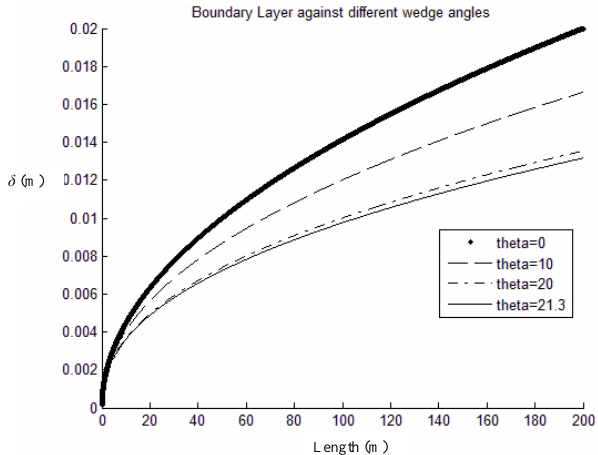
Fig. 3. The boundary layer depth against the length of the channel Fig 3. The boundary layer depth against the length of the channel (in non-dimensional form) has (in non-dimensional form) has been plotted for different wedge an- gles. If can be observed that as the inclination angle increases, the been plotted for different wedge angles. If can be observed that as the inclination angle increases, depth of the boundary layer the depth of the boundary layer reduces.